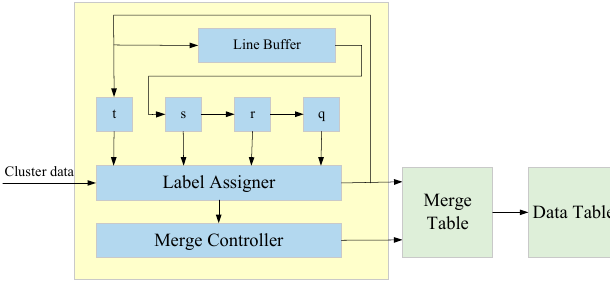
Figure 12. Hardware architecture of the CCL module.